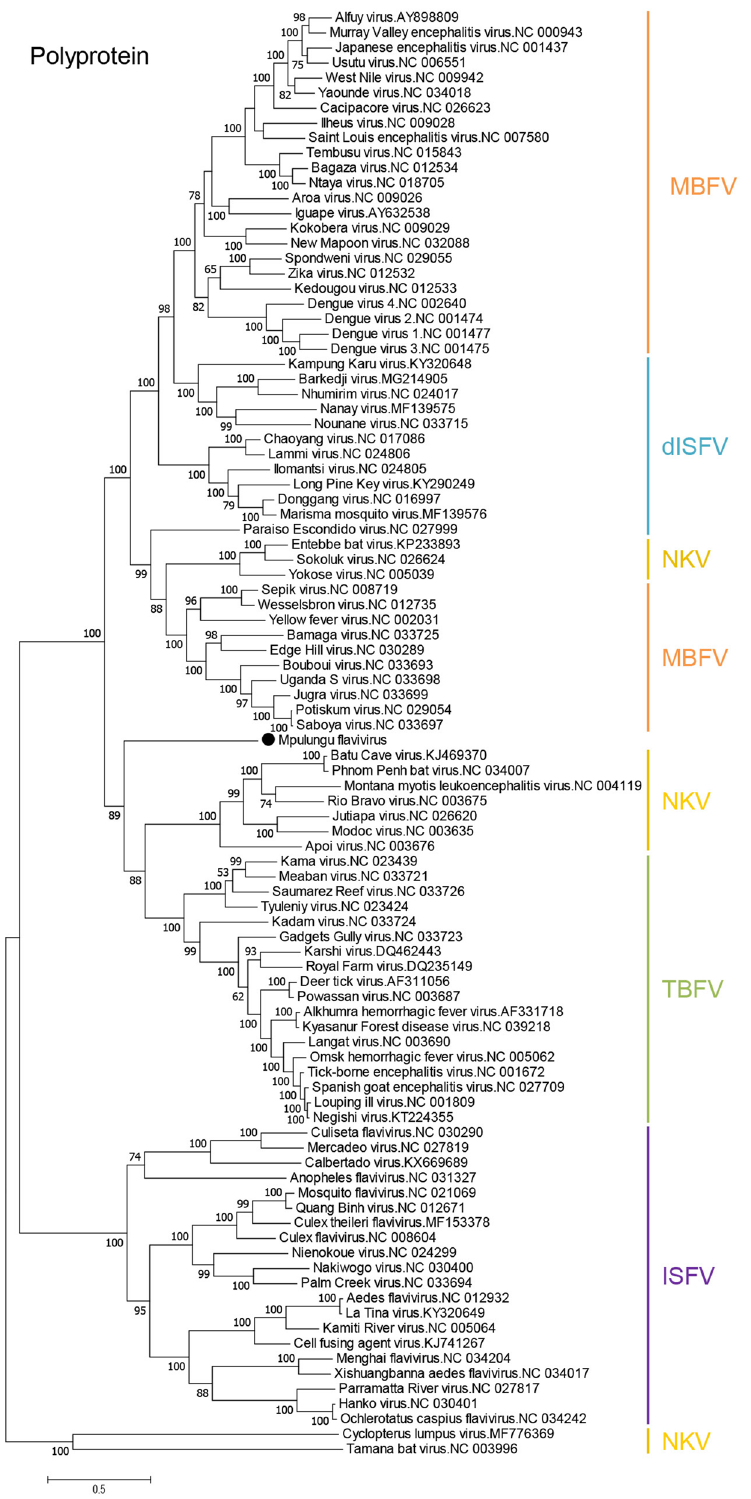
Figure 2. Phylogenetic analyses of flaviviruses. A phylogenetic tree based on amino acid sequences of the polyprotein was constructed using the maximum likelihood method with 1000 bootstrap replications. Bootstrap values > 50% based on 1000 replications are shown on the interior branch nodes. Scale bar 0.5 substitutions per site. Group names are indicated on the tree with abbreviations as follows: TBFV tick-borne flavivirus, MBFV mosquito-borne flavivirus, ISFV insect-specific flavivirus, dISFV dual-host affiliated insect-specific flavivirus, NKV no known vector. Black circle represents